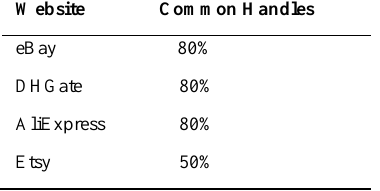
Table 3. Shopping websites with similar handles.